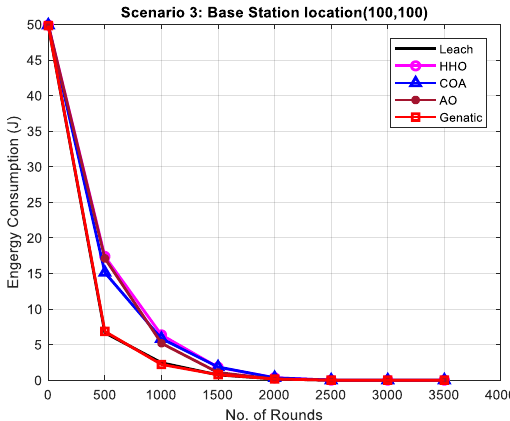
Figure 7. Energy consumption in case of scenario 2: BS at (50,50).